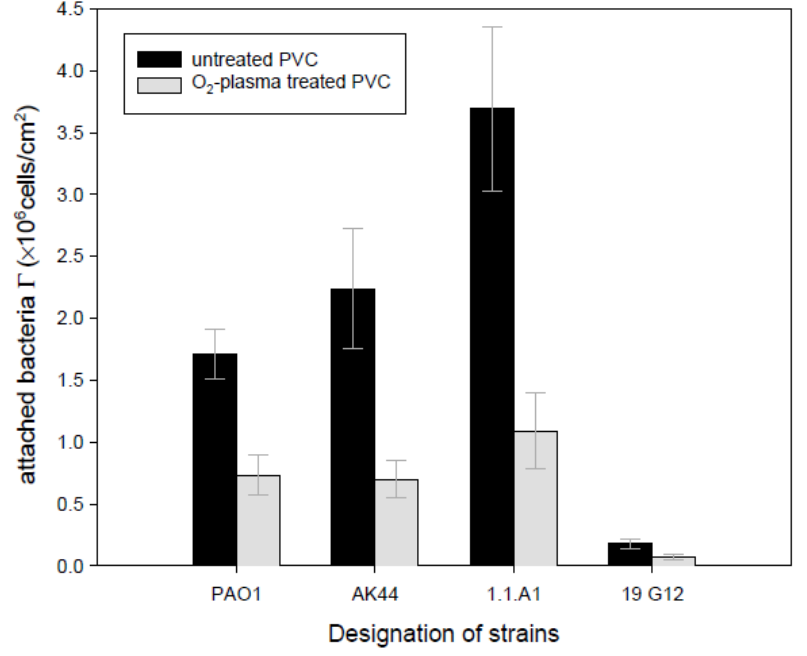
Figure 14. Adhesion effectiveness of a subset of Pseudomonas aeruginosa strains to oxygen plasma-treated PVC as compared to untreated PVC (Reprinted with permission from [91]. Copyright 2003 Elsevier).